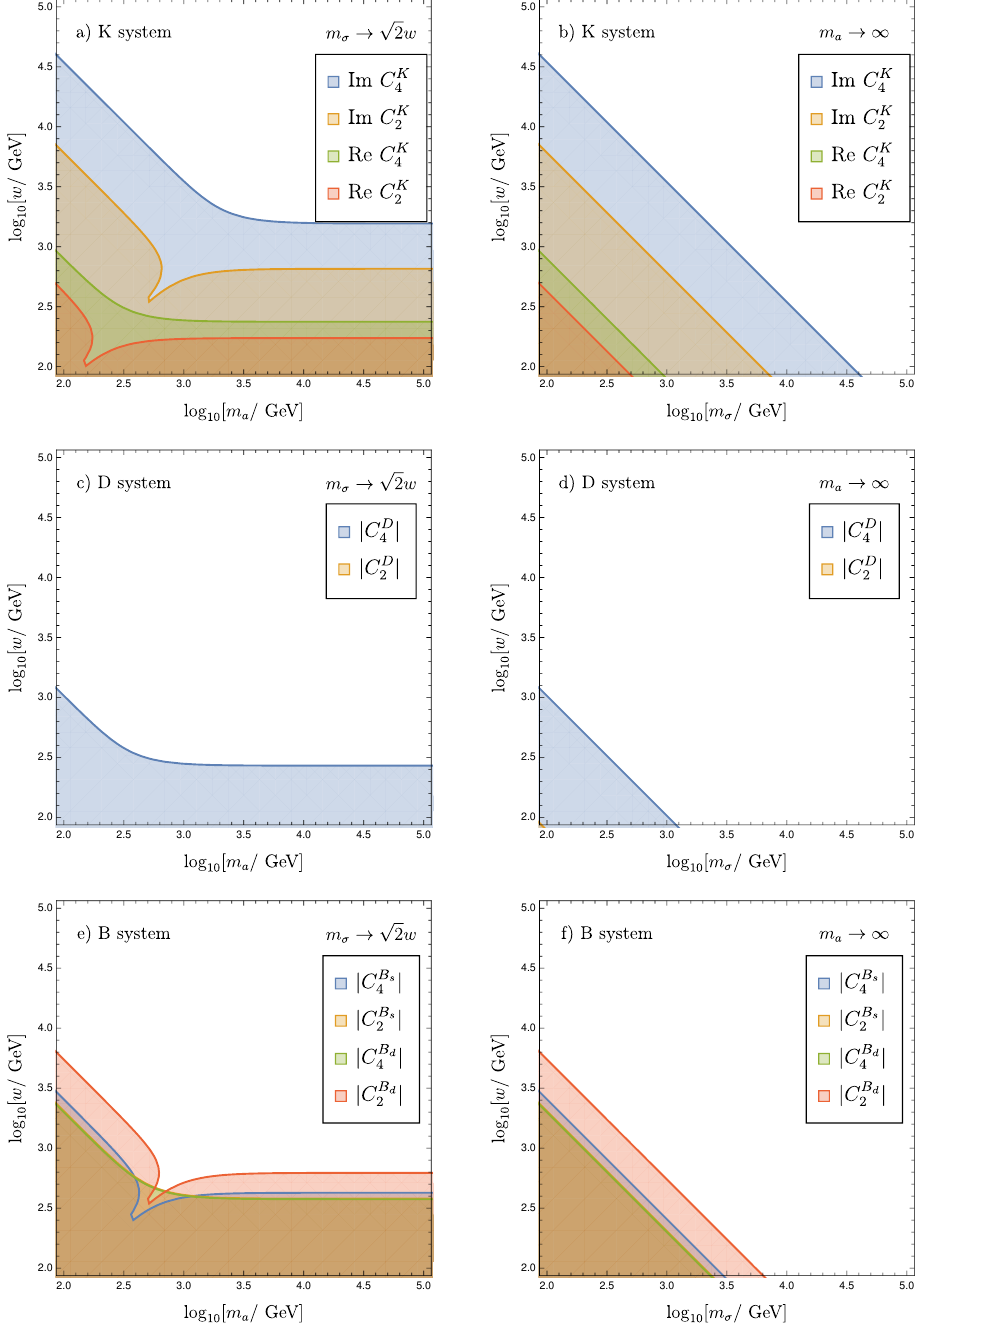
Figure 7 . Meson mixing exclusion limits for all K, D, B s , B d systems in di(cid:11)erent regions of the p parameter space (left: m (cid:27) = 2 w , right: m a ! 1 ).